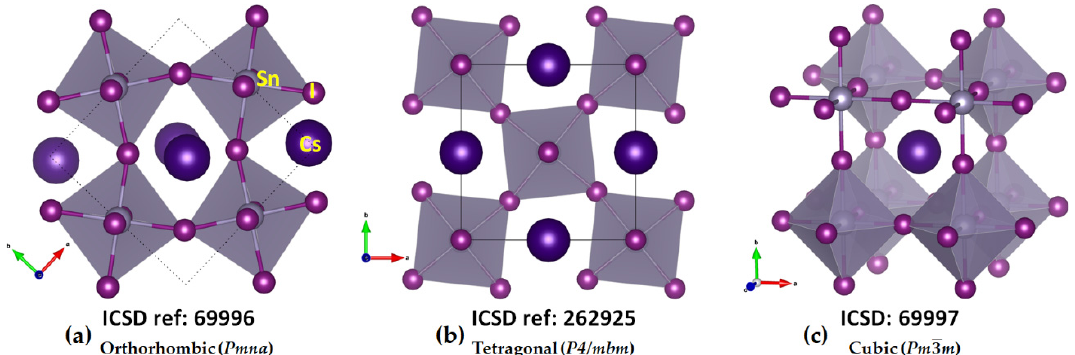
Figure 1. Mixed polyhedral and ball-and-stick models of crystal structures of the semiconductor CsSnI 3 in the low- and high-temperature phases: ( a ) orthorhombic ( γ -phase); ( b ) tetragonal ( β -phase); ( c ) cubic ( α -phase) [54]. Atom labeling is shown in ( a ). Each polyhedron represents the SnI 64 − octahedron. The ICSD reference code is shown in each case.